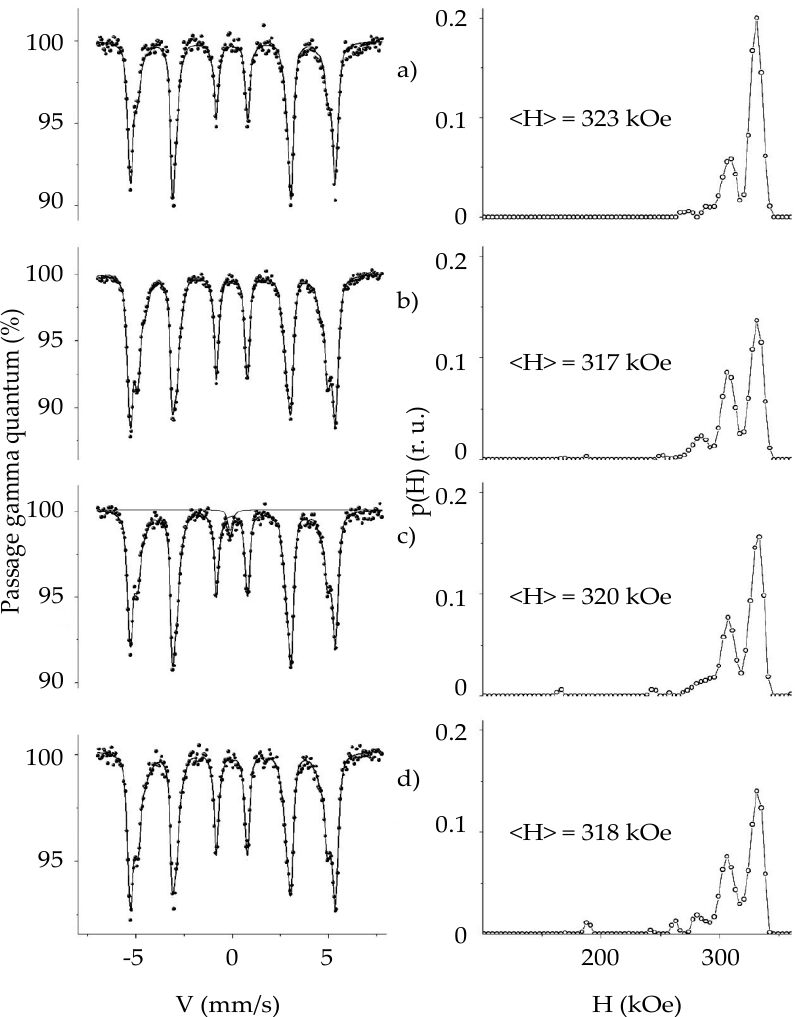
Figure 3. Mössbauer spectra of alloys Fe-4.10 and 7.25 at.% Mn and calculated distributions of effective magnetic fields P ( H ) in the α -phase: ( a )—Fe-4.10 at.% Mn (quenching + HPT+ irradiation); ( b – d )—Fe-7.25 at.% Mn: ( b )—quenching + irradiation, ( c )—quenching + HPT + irradiation (sextet— depleted α-phase, singlet—γ-phase), ( d )—quenching + HPT.